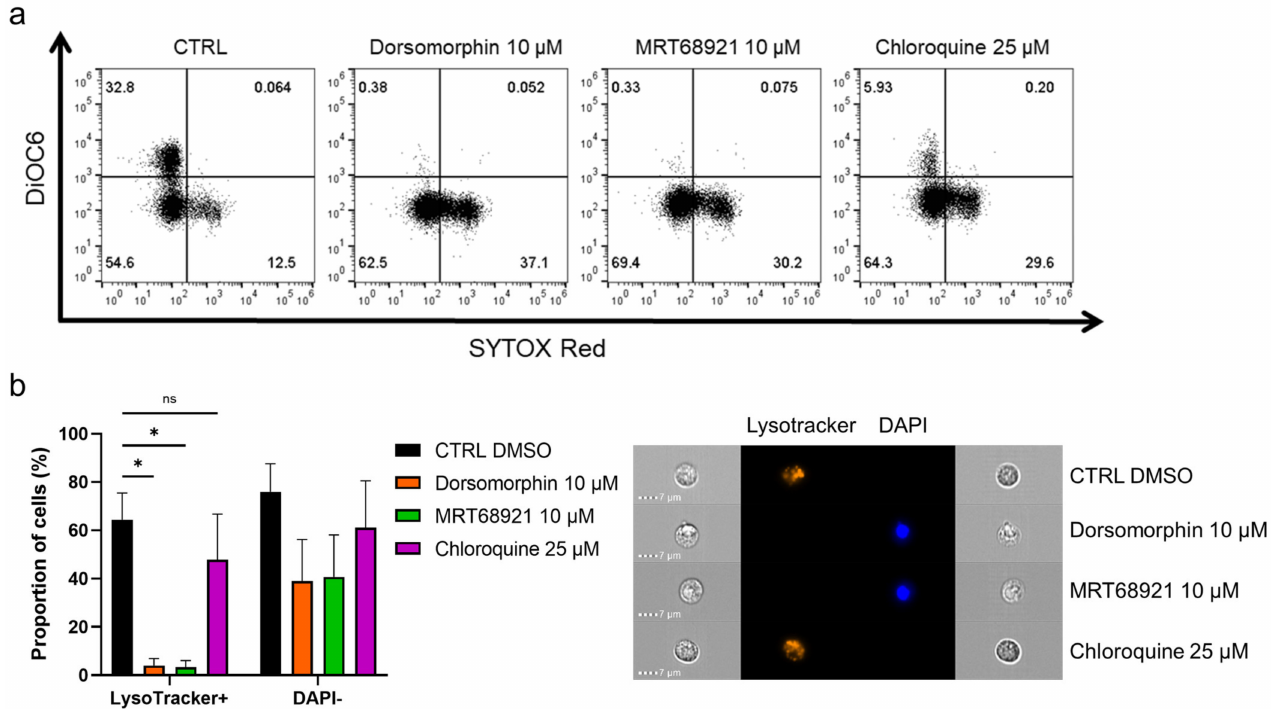
Figure 4. Autophagy inhibitors dorsomorphin, MRT68921, and chloroquine treatments for 24 h disrupt mitochondrial membrane potential and decrease lysosomal integrity in patient-derived CLL cells. ( a ) Representative dot plot diagram of mitochondrial membrane potential and cell viability. ( b ) Autophagy inhibitors perturb lysosomal integrity and decrease cell viability of primary CLL cells. The proportions of LysoTracker+ cells (high lysosomal integrity, viable cells) and DAPI − cells (viable cells) were determined using imaging flow cytometry. Representative cell images are shown. Data are means ± SEM of 3 independent experiments. Not significant (ns) and ∗ denote p > 0.05 and p < 0.05,